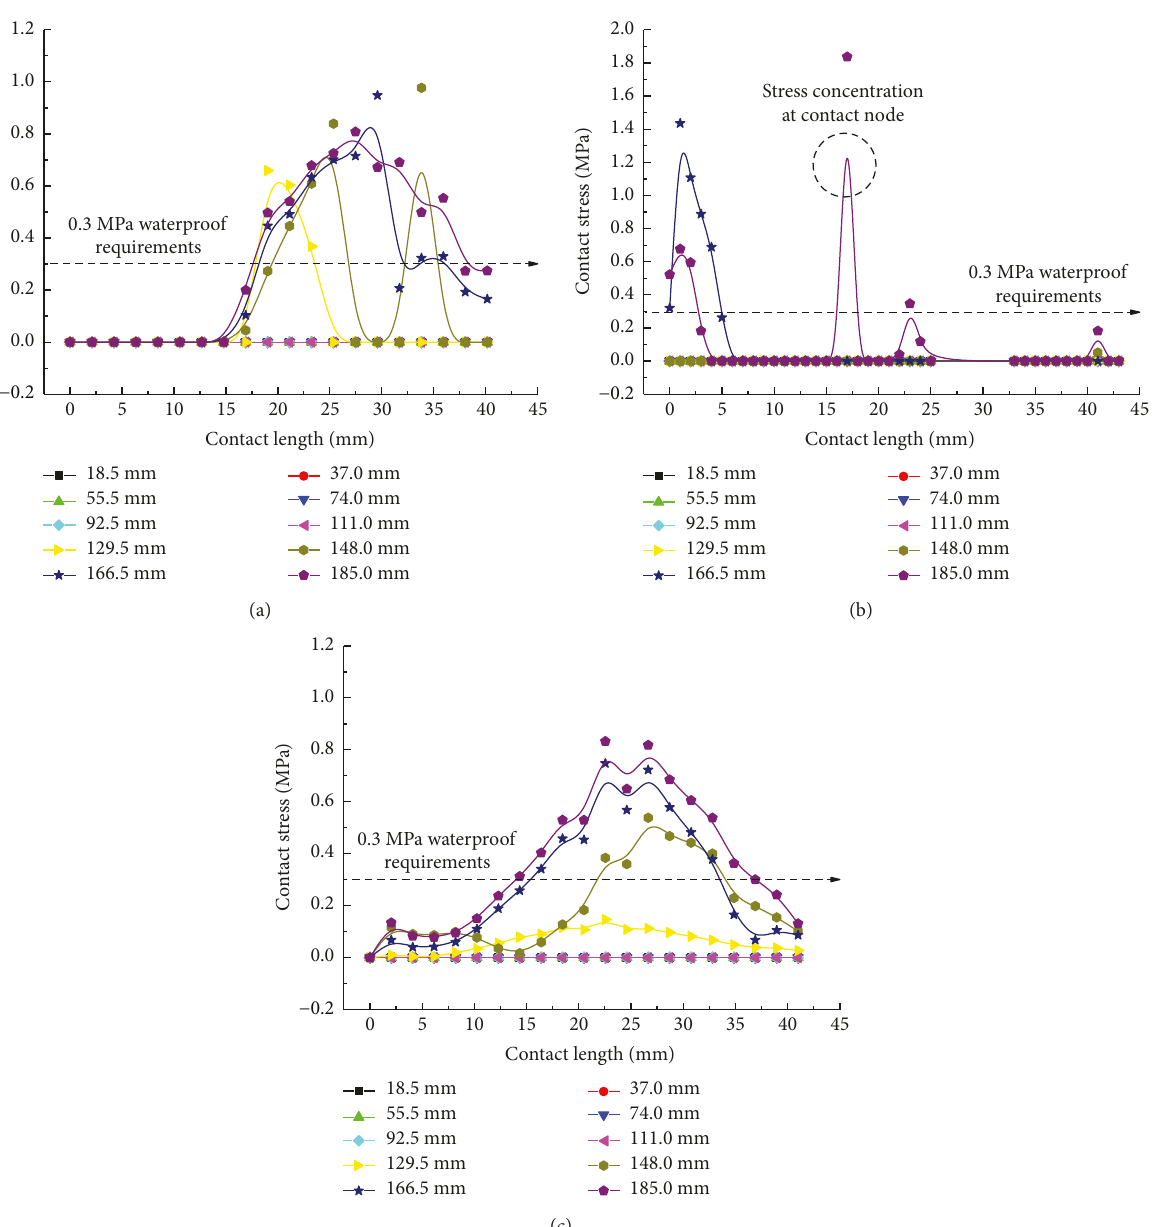
Figure 10: Contact stress curve of the second rubber ring after optimizing during translation: (a) contact pressure of line 1 for the second rubber ring, (b) contact pressure of line 2 for the second rubber ring, and (c) contact pressure of line 3 for the second rubber